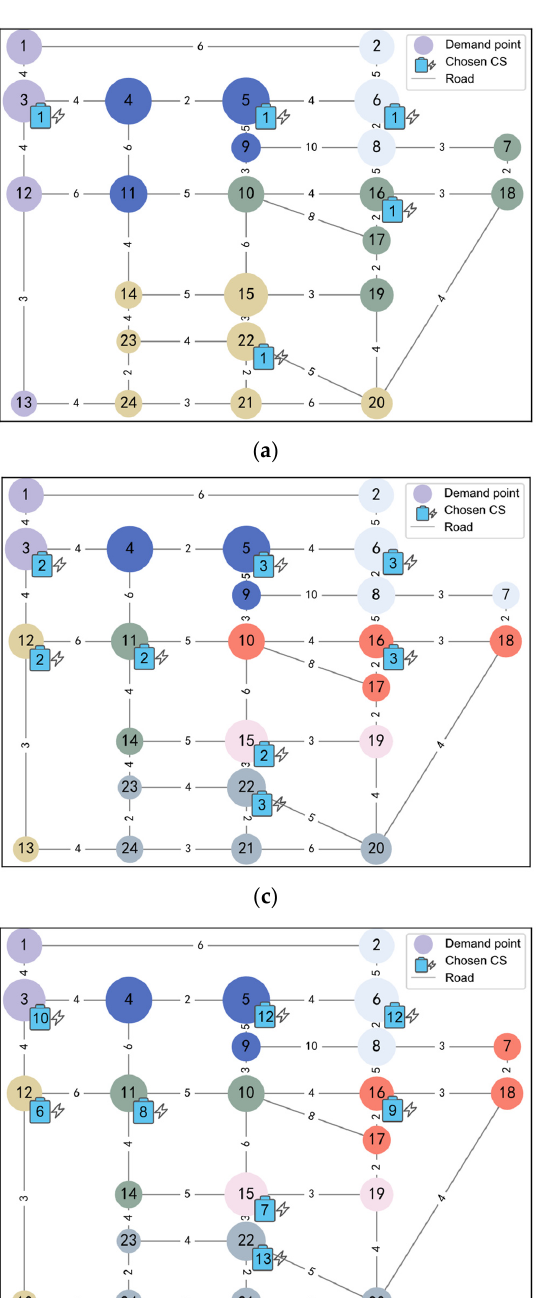
Figure 6. Optimization results based on the Sioux Falls road network. The above layout characteristics of CSs in the sub-networks are fully reflected at all stages except for some seemingly abnormal phenomenon. In Figure 5d, not like in Figure 5c, some EVs at demand points do not go to the nearest CSs but a farther one, such as the EV at demand point 10, which goes to CS 11 for charging but not to CS 16. This sub-opti- mal phenomenon is mainly caused by two reasons; one is that the overload operation of the nearest CS and the new added charging demand will lead to another new built CS and higher cost, and the other reason is that the farther charging selection will decrease the total number of FCPs and the cost savings will cover the detour cost of the EV users.